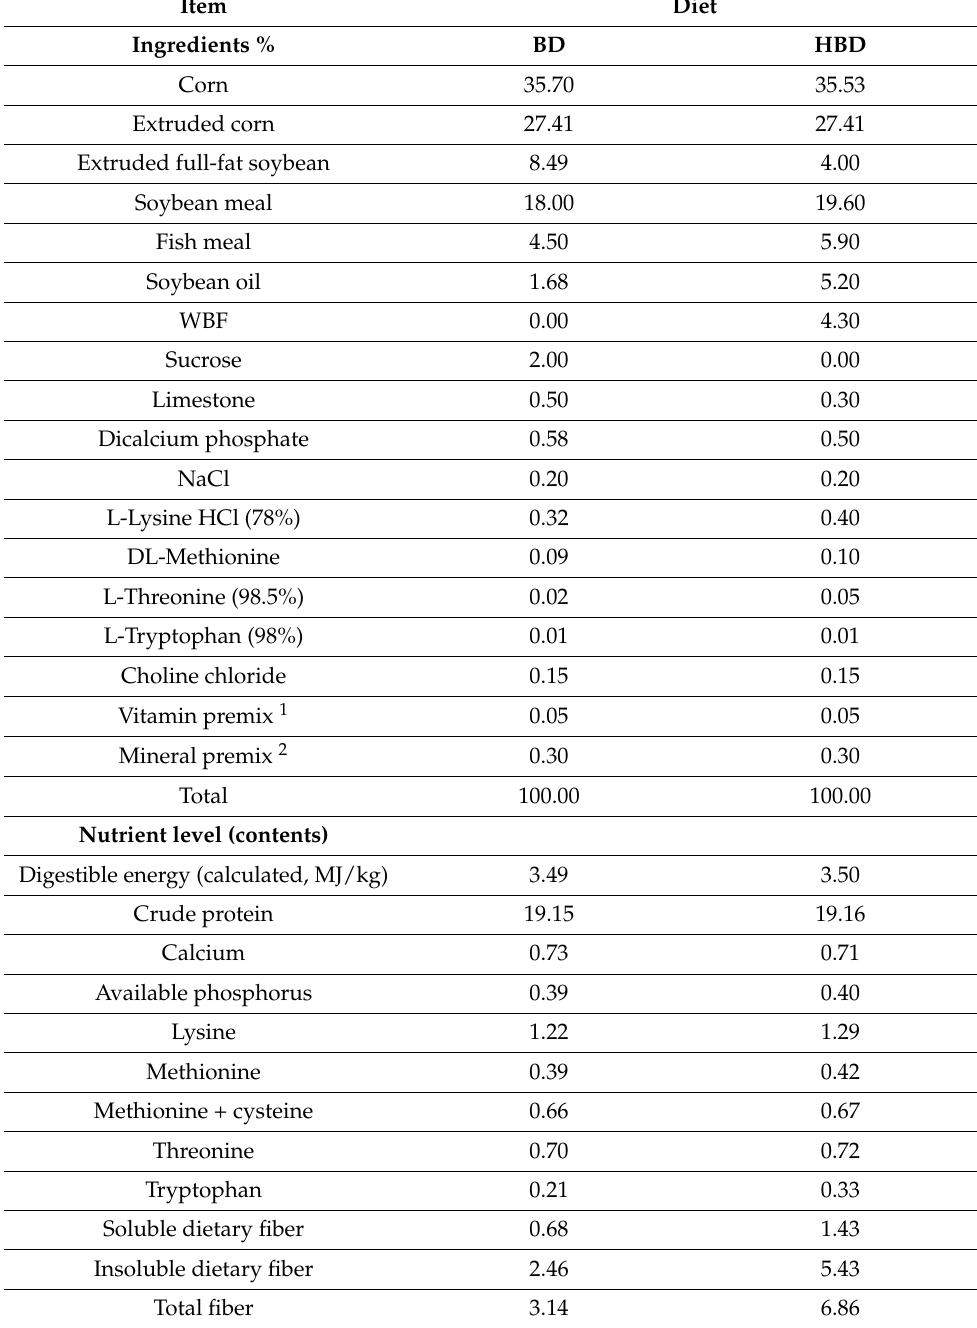
Table 1. Ingredients and nutrient composition of the basal and high-fiber diet